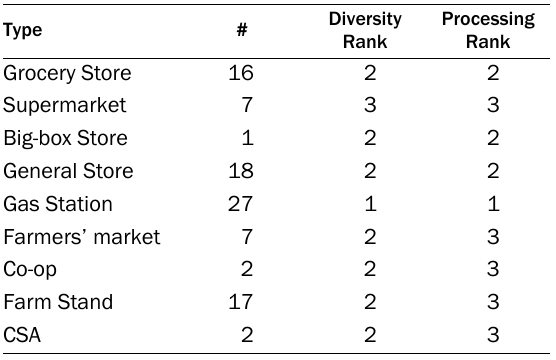
Table 2. Summary of Ranking Values Used To Reclassify Food Sources in Rutland